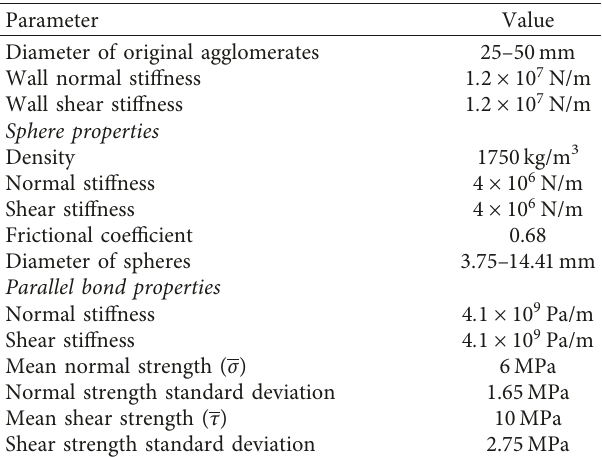
Table 2: Parameters of DEM